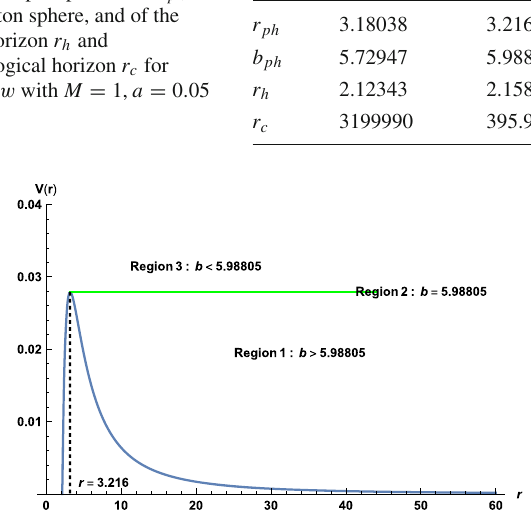
, while Region 1 and Region (green lines) correspond to V ( r ) = 1 / b 2 ph and V ( r ) > 1 / b 2 , 3 correspond to V ( r ) < 1 / b 2 ph ph